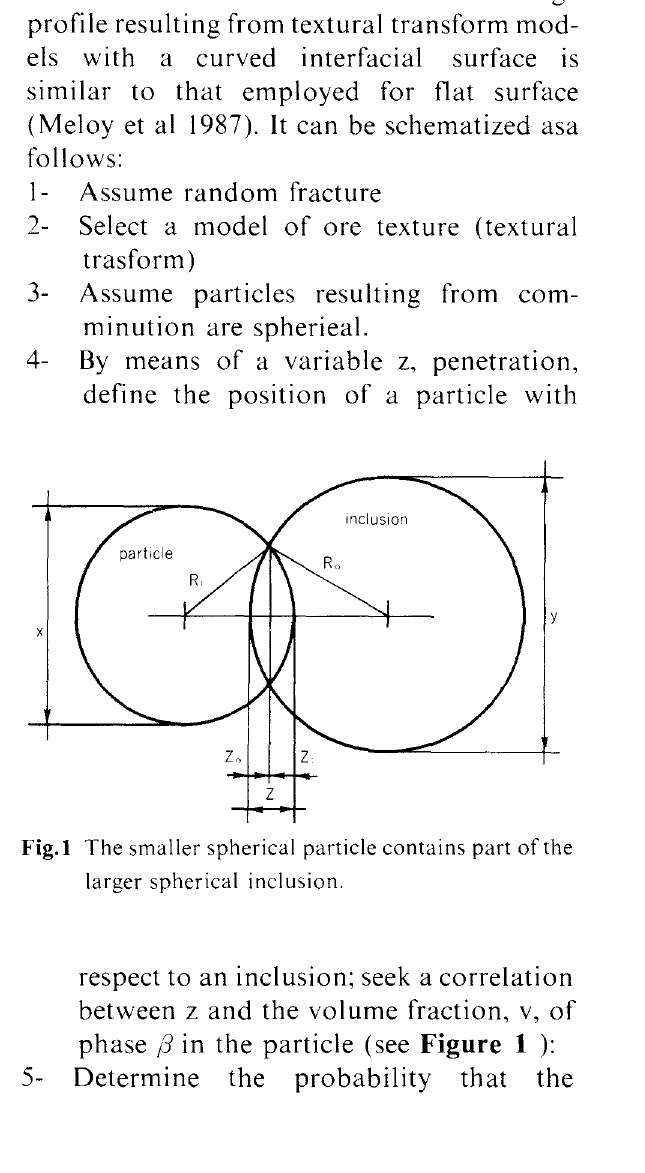
Fig. I The smaller spherical particle contains part of the larger spherical